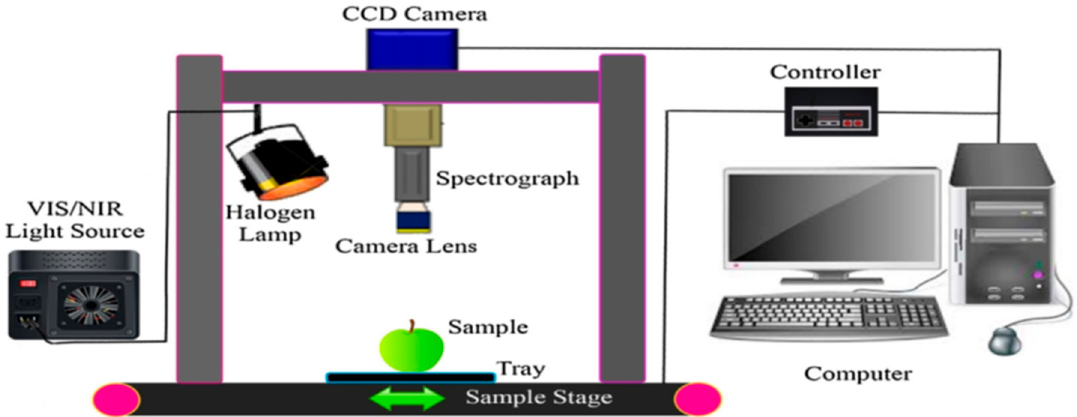
Figure 1. The components of a push-broom hyperspectral imaging system [10].